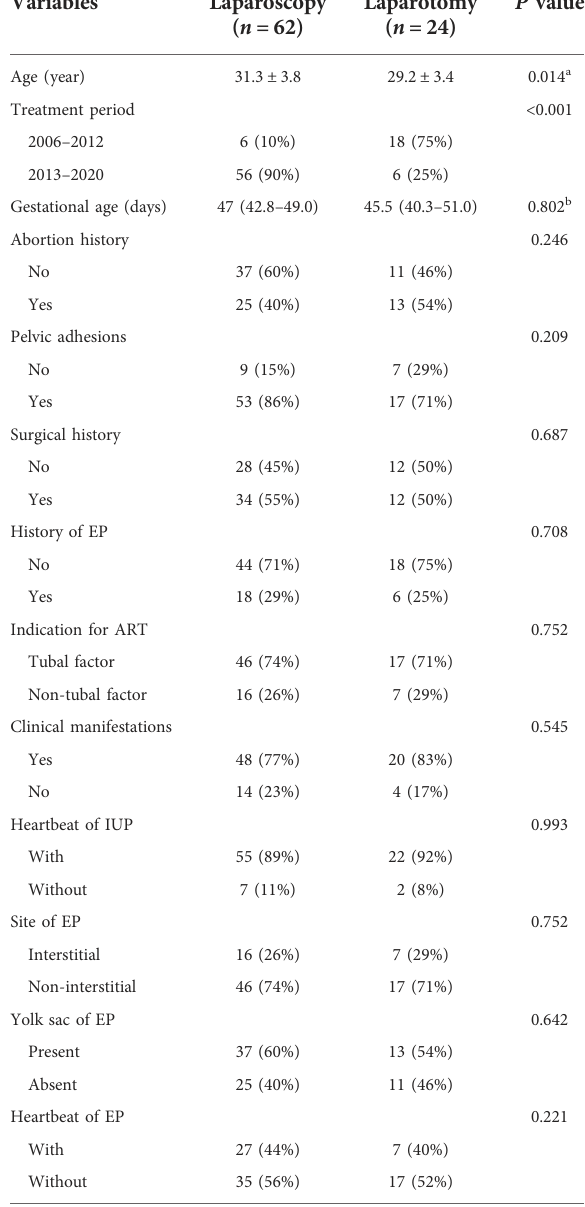
TABLE 1 Baseline characteristics of patients in two